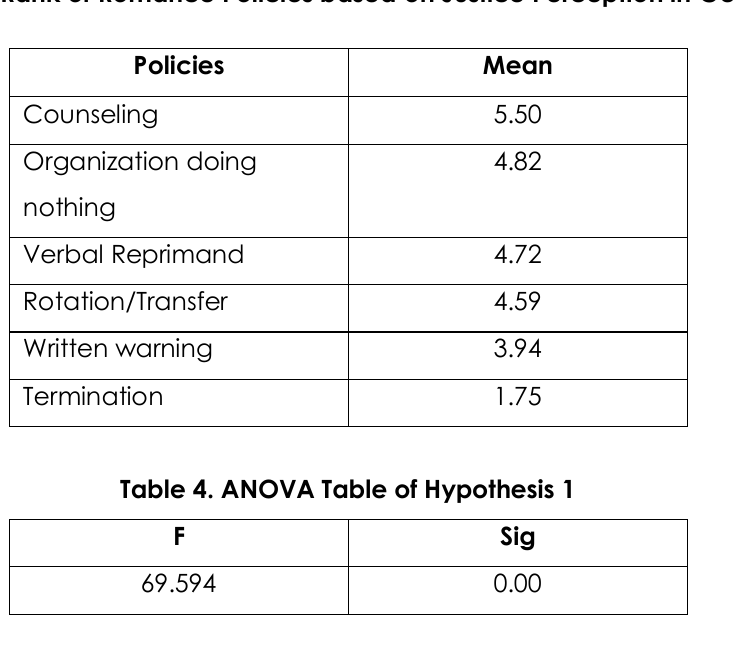
Table 3. Rank of Romance Policies based on Justice Perception in General